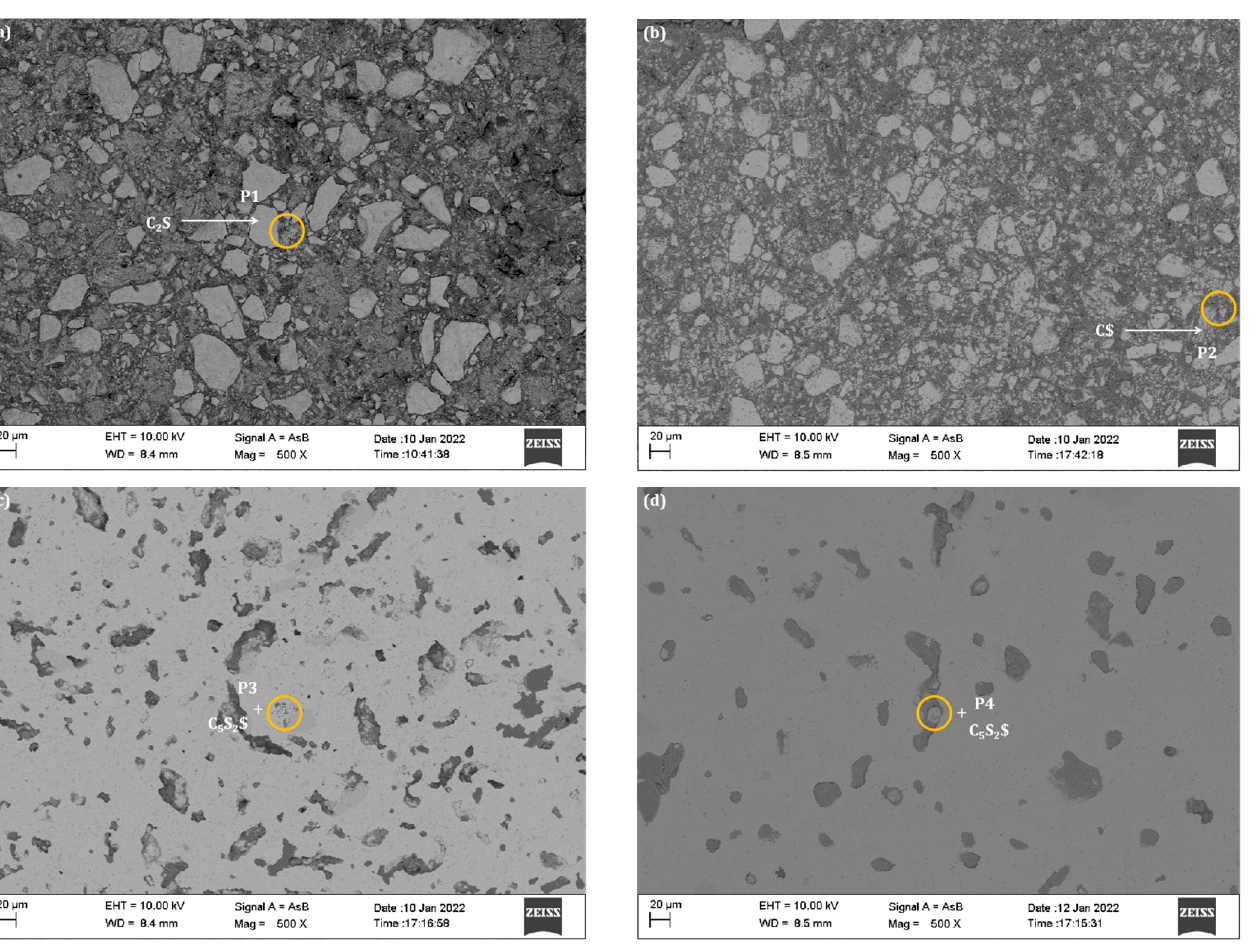
Figure 9. BSE images of the samples: ( a ) is the raw mixture of β -C 2 S and CaSO 4 ∙ 2H 2 O, ( b ) is sample treated at 1100 °C for 0 h, ( c ) is sample treated at 1100 °C for 1 h, ( d ) is sample treated at 1100 °C for 12 h. The inset of all EDS analysis represents the spectra of the marked spots in the images, where P1 represents C 2 S, P2 represents CaSO 4 , and P2 and P3 represent C 5 S 2 $. The black area represents the portion of the pore filled with epoxy resin.